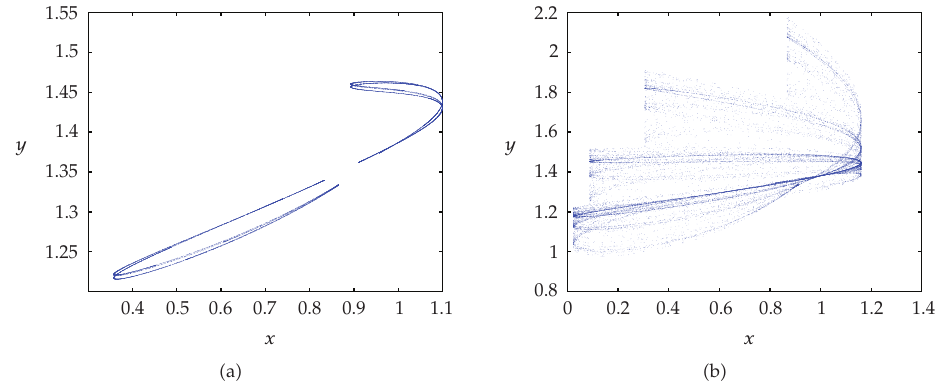
Figure 3: For system (cid:2) 5.3 (cid:3) with k (cid:7) 0 . 2. (cid:2) a (cid:3) Chaotic attractor versus α 1 (cid:7) 0 . 24; (cid:2) b (cid:3) chaotic attractor versus α 1 (cid:7) 0 . 27.